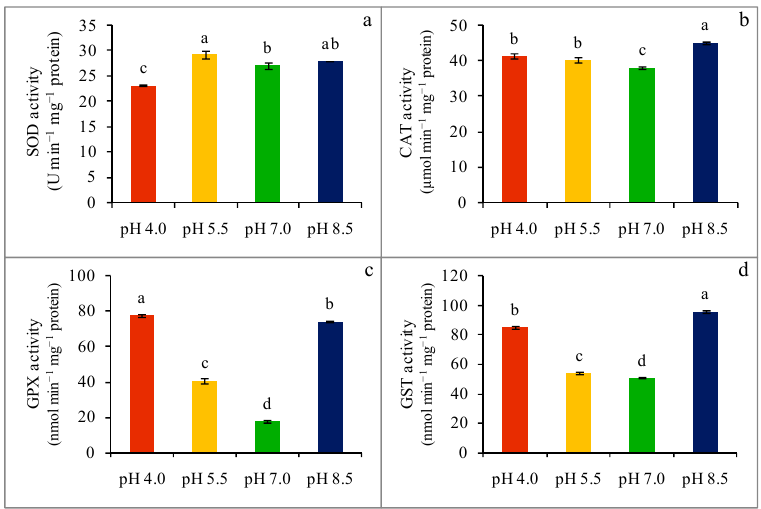
Figure 6. Activities of SOD ( a ), CAT ( b ) GPX ( c ), and GST ( d ) of wheat leaves under different levels of pH. Mean (±SD) was computed from three replications of each treatment. Bars with dissimilar letters are significantly different at p ≤ 0.05 from Fisher’s LSD test.